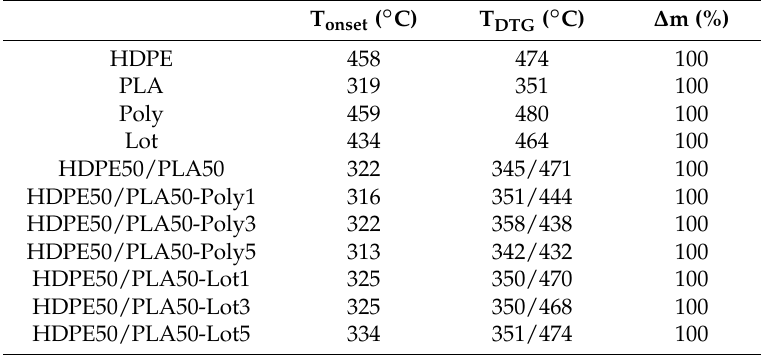
Table 6. TGA results for HDPE/PLA blends with different compatibilizer percentages and HDPE50/PLA50 matrix composites with 3 wt.% of compatibilizer. T onset (°C) was evaluated with the extrapolated onset temperature from the TGA curve. T DTG (°C), temperature of maximum differential thermogravimetric analysis (DTG) curve peaks; ∆ m (%) is the mass variation percentage between sample’s total mass before the test and the residual mass after the test.